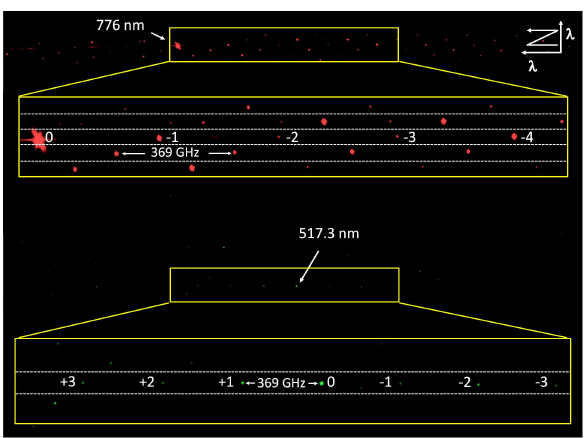
Figure 10: Selected portion of visible spectra recorded from the CCD camera and zoomed-in images near 776 nm and 517 nm spectral regions. The direction of the wavelength is shown in top right of the figure. The white dotted lines represent the boundary between different grating orders. Both visible combs have repetition rates of 369 GHz, which is the same as the initial IR comb repetition rate. IR: infrared.